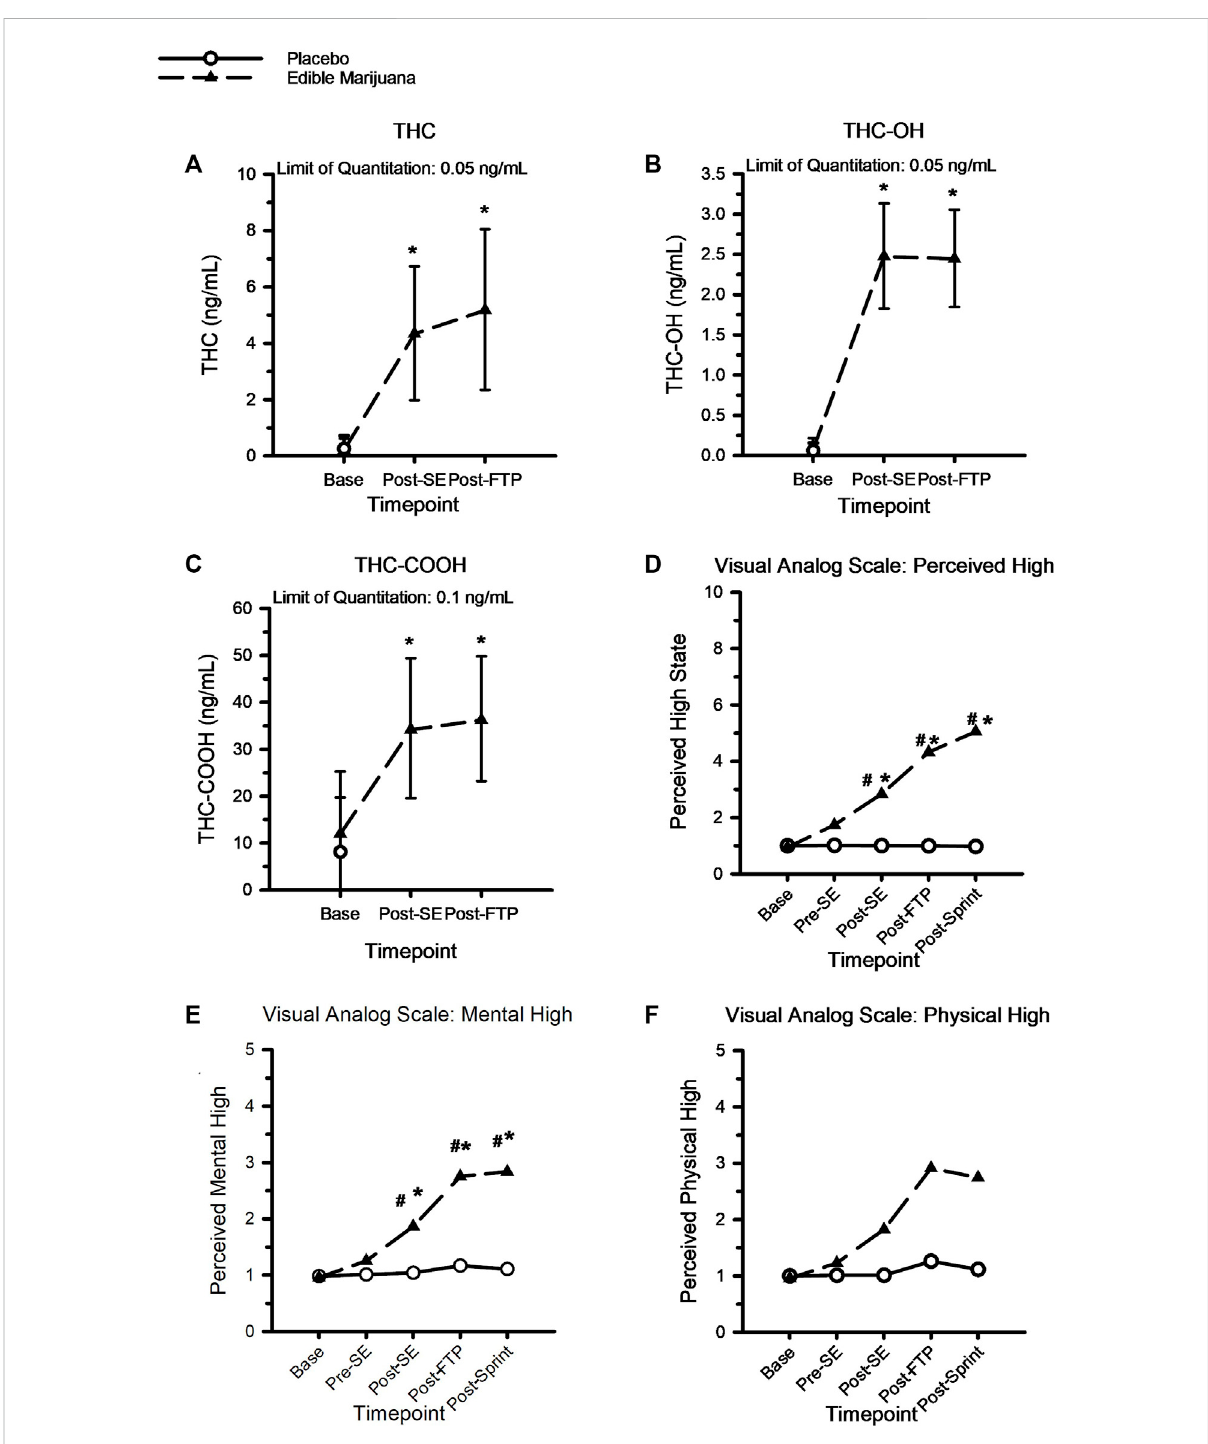
FIGURE 2 A-to-C: Circulating concentration of THC (A) , THC-OH (B) and THC-COOH (C) following ingestion of edible marijuana (10 mg of THC). Data are mean and SD. D-to-F, Visual analog scores of perceived intoxication speci fi c to “ High ” (D) , Mental High (E) and Physical High (F) following ingestion of edible marijuana and placebo. For all fi gures, * depicts different from baseline ( p < 0.05), # depicts different between conditions ( p < 0.05). For the visual analog fi gures, error bars have been omitted for